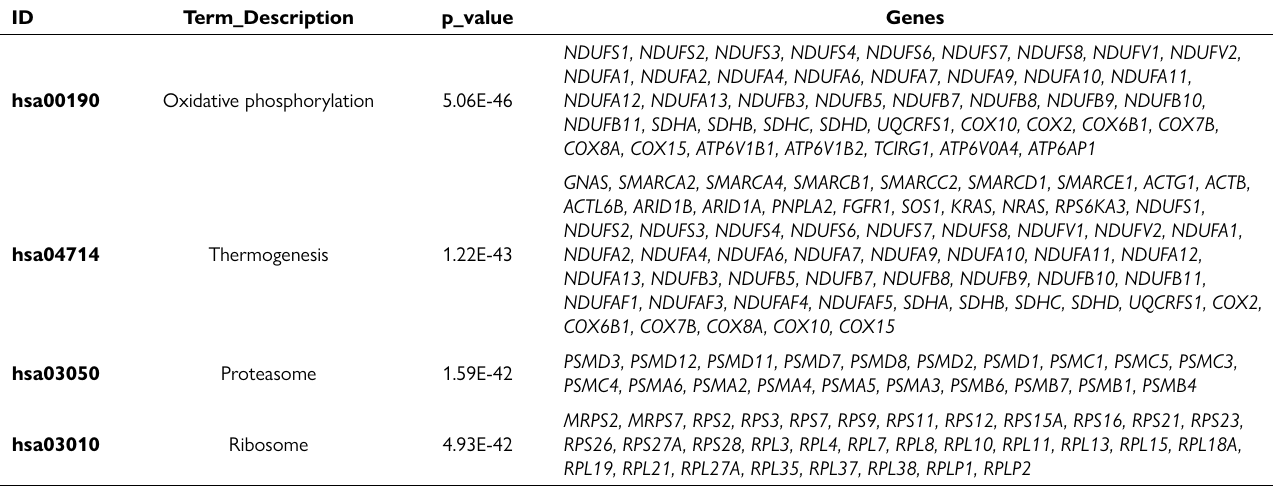
Table 2. Enriched pathways related to the hearing loss gene